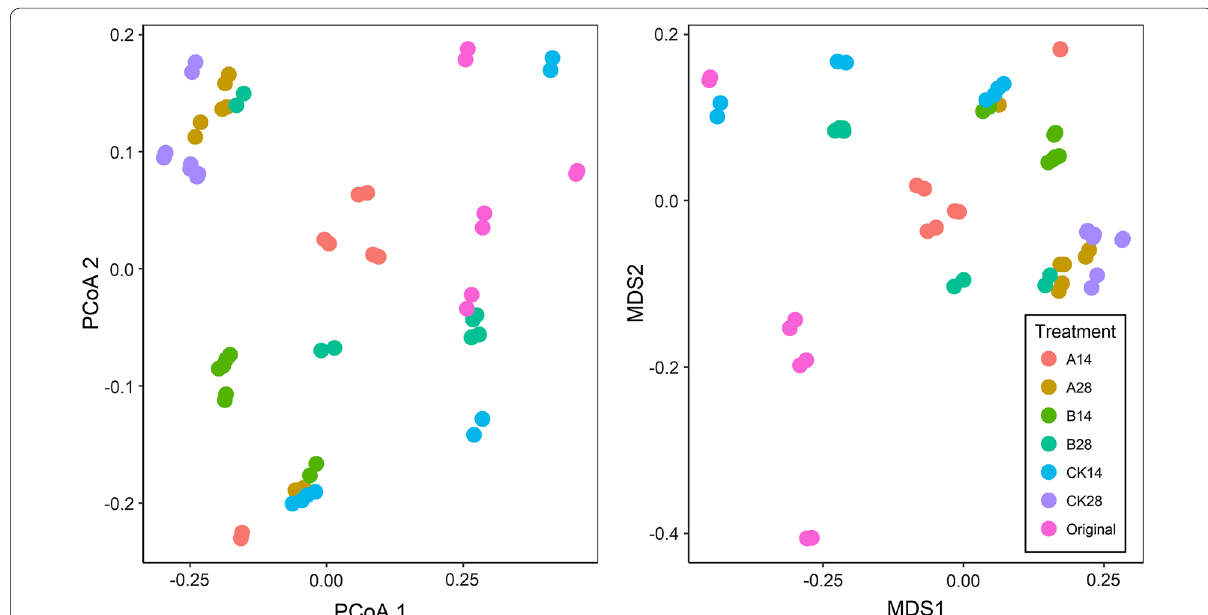
Fig. 4 Phylogentic beta-diversity of phyllosphere microbial community as indicated by principal coordinates analysis (PCoA) and non-metric multidimensional scaling (NMDS)